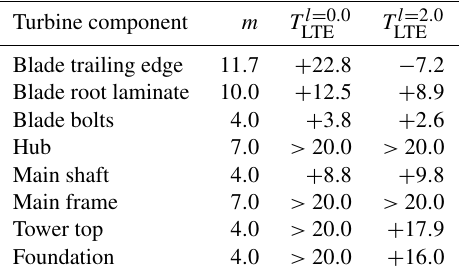
Table 3. Lifetime extension of components in years.